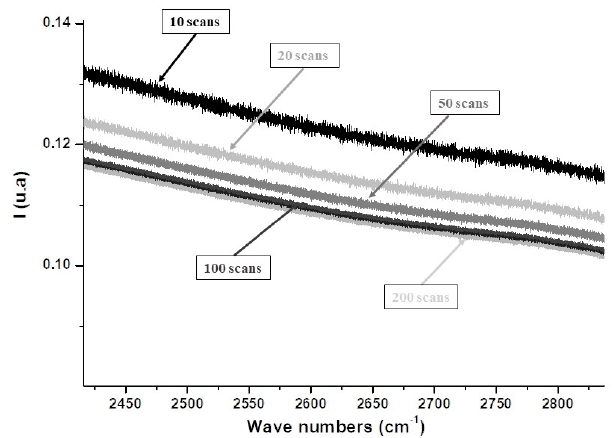
Figure 2. Improvement of the SNR with different scan numbers and a fixed scan speed of